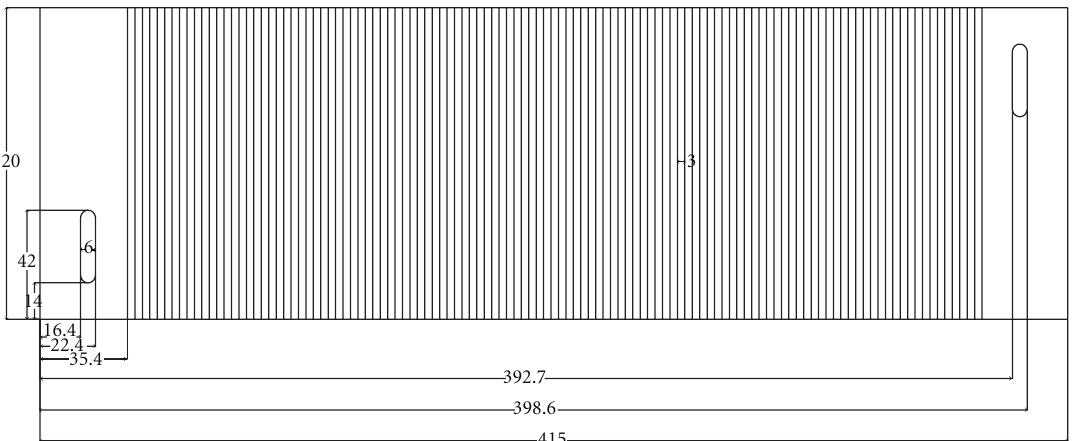
Figure 2: Flow field design for air supply/coolant.